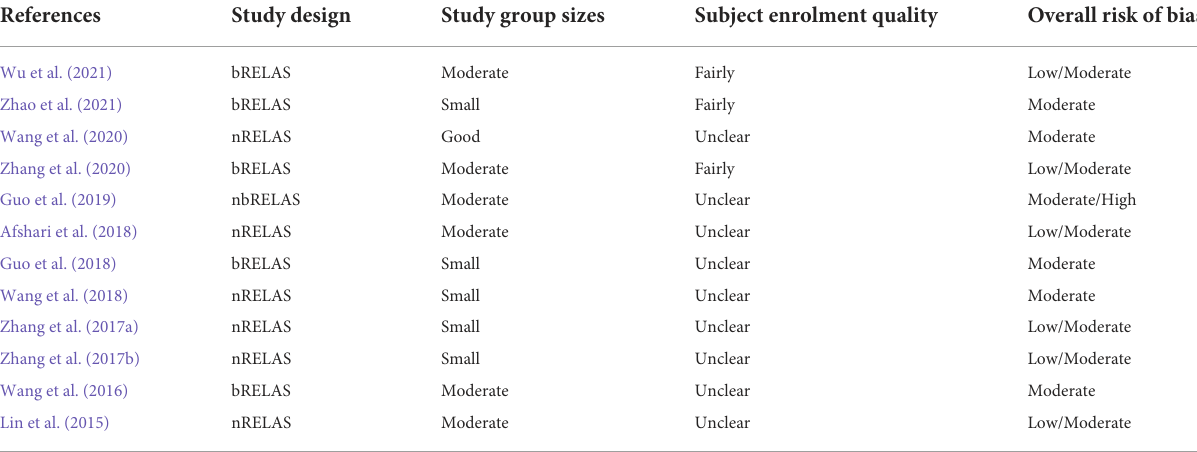
TABLE 3 Summaries of the quality of evidence of included